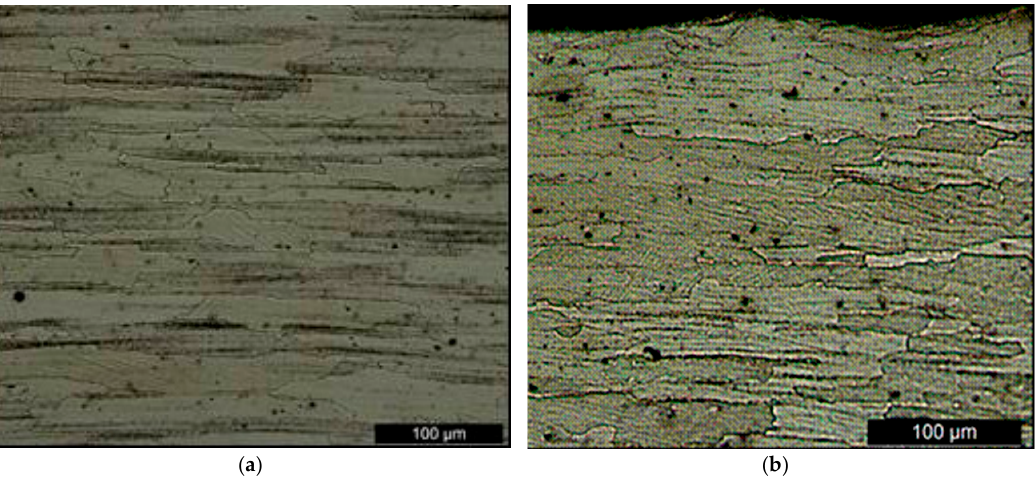
Figure 2. Microstructure micrographs: ( a ) base material; and ( b ) shot peening (SP) sample.